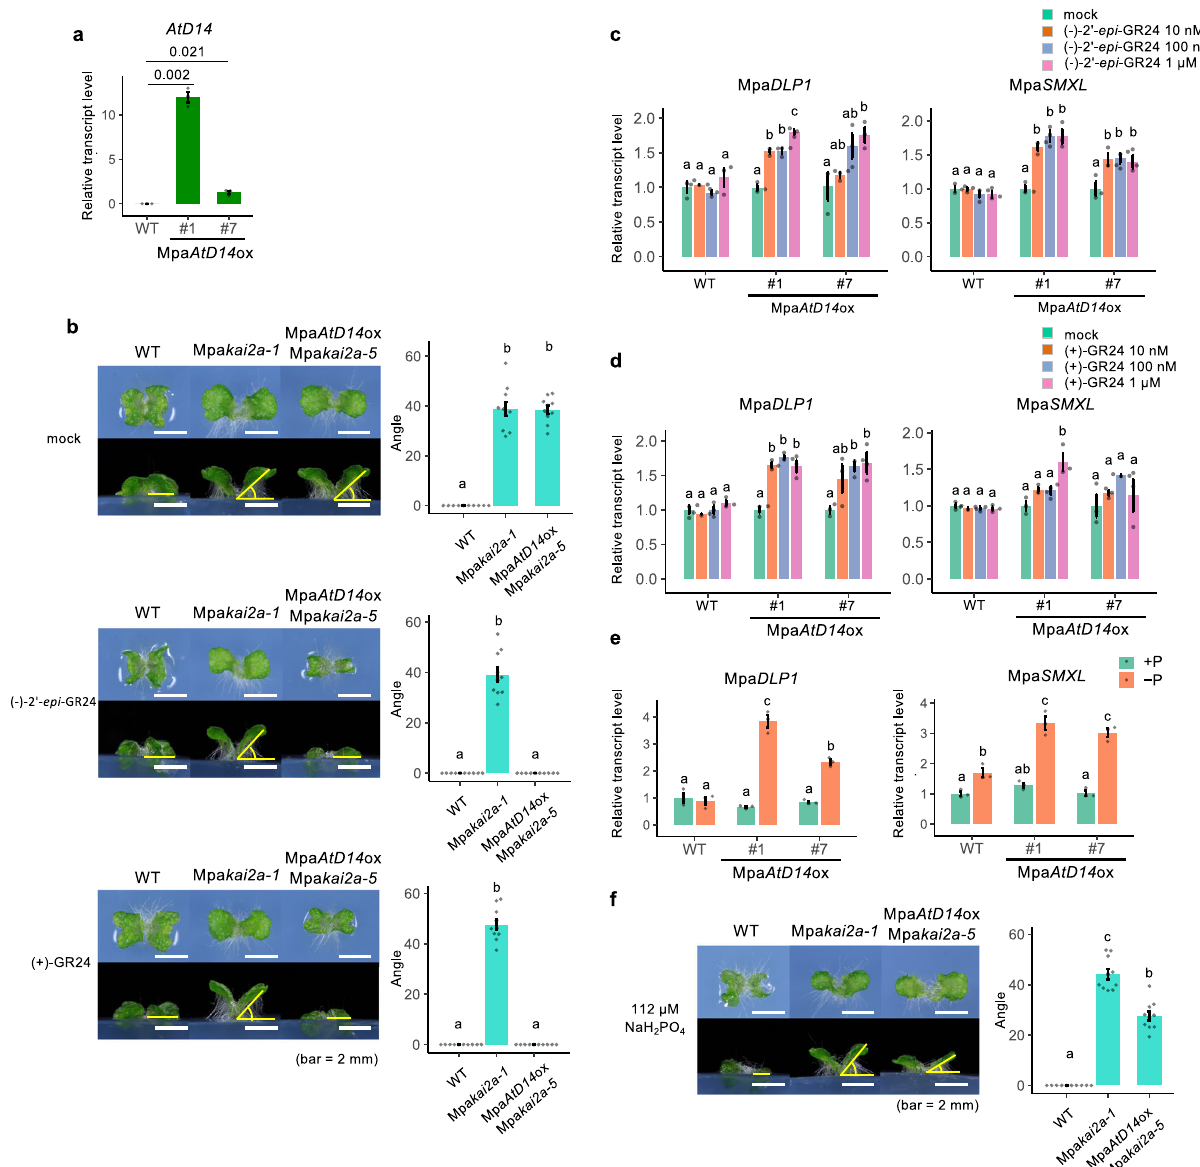
Fig. 7 Heterologous expression of AtD14 , the SL receptor of Arabidopsis, renders M. paleacea cells BSB-responsive. a Transcript level of AtD14 introduced into M. paleacea . Data are means ± SD ( n = 3 biologically independent samples), and p values in Welch ’ s t -test, two tailed are indicated. b Complementation of Mpa kai2a phenotypes in Mpa AtD14 ox/Mpa kai2a ( M. paleacea ) lines by addition of 1 μ M ( − )-2 ′ - epi -GR24 or 1 μ M ( + )-GR24. Data are means ± SD ( n = 10 biologically independent plants). c , d Induction of Mpa DLP1 and Mpa SMXL , marker genes of KAI2-dependent signaling, in response to SL treatment. Transcript level of Mpa DLP1 and Mpa SMXL in WT and Mpa AtD14ox lines in M. paleacea after ( − )-2 ′ - epi -GR24 ( c ) or ( + )-GR24 ( d ) treatment are shown. Data in c , d are means ± SD ( n = 3 biologically independent samples). e Induction of Mpa DLP1 and Mpa SMXL transcript level by phosphate starvation in Mpa AtD14 ox lines of M. paleacea . Data are means ± SD ( n = 3 biologically independent samples). f Complementation of Mpa kai2a phenotypes in Mpa AtD14 ox/Mpa kai2a ( M. paleacea ) lines grown on media with a reduced phosphorus level. Data are means ± SD ( n = 10 biologically independent plants). The HSD test was used for multiple comparisons in b – f . Statistical differences ( p values < 0.05) are indicated by different letters in b – f